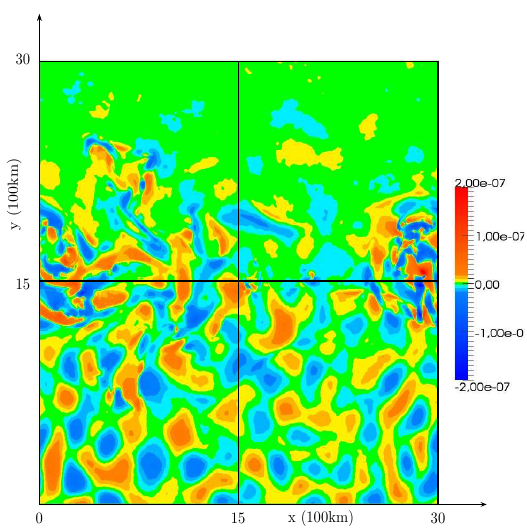
Fig. 3. Divergence of the upper layer (in s − 1 ) after 250 days in exp11. The accumulation of wave activity is clearly visible in the southern part of the domain. As is the dominance of structures of scale above the (baroclinic) deformation radius.